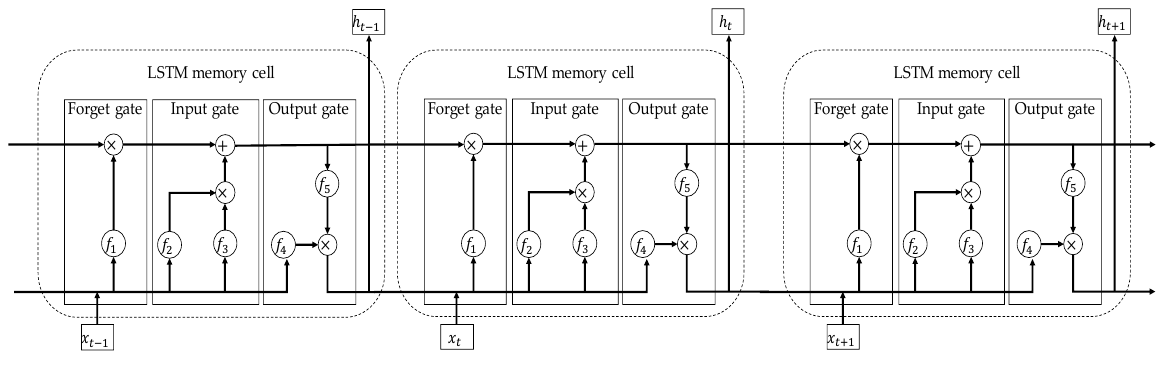
Figure 6. Schematic diagram for the Bi-LSTM.